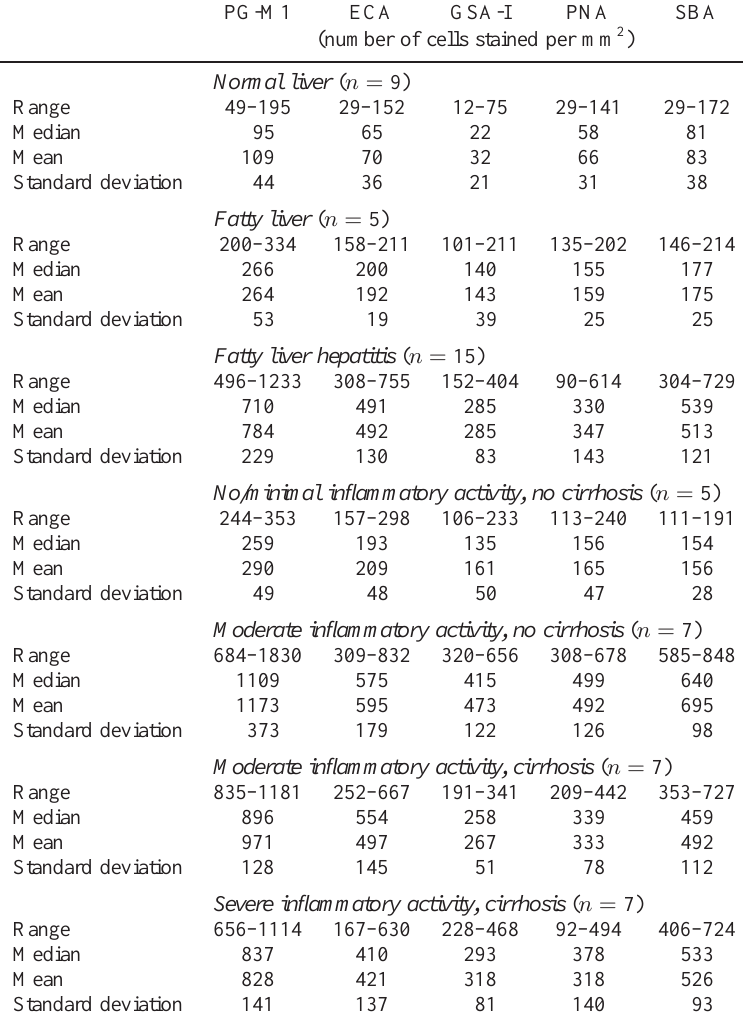
Table 3 Morphometric analysis of macrophages in the portal fields of normal and fatty livers, fatty liver hepatitis and HBV-infected livers (ranges, medians, means and standard